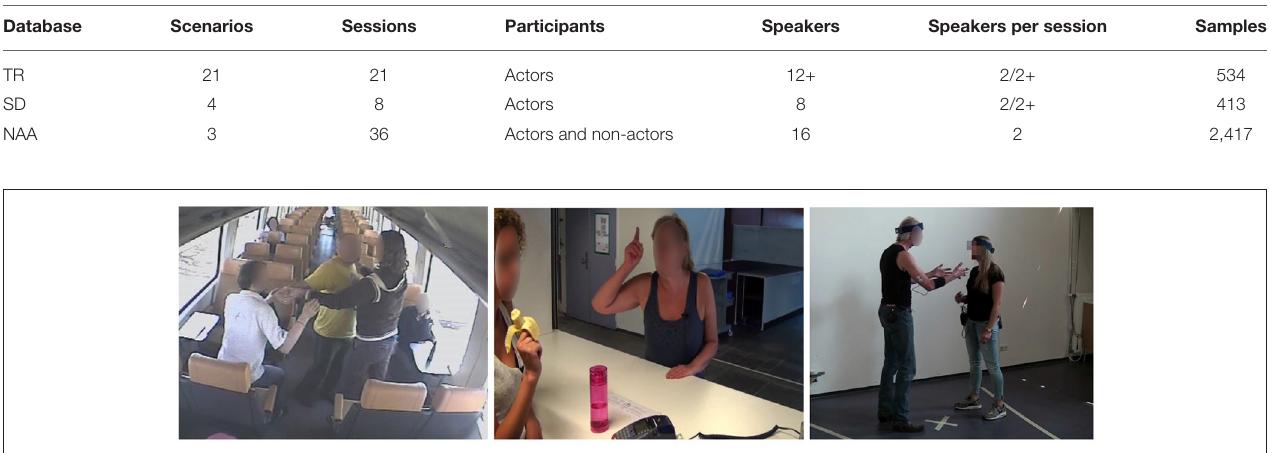
FIGURE 1 | From (left) to (right) TR, SD, and NAA corpora stills taken from the video modality.